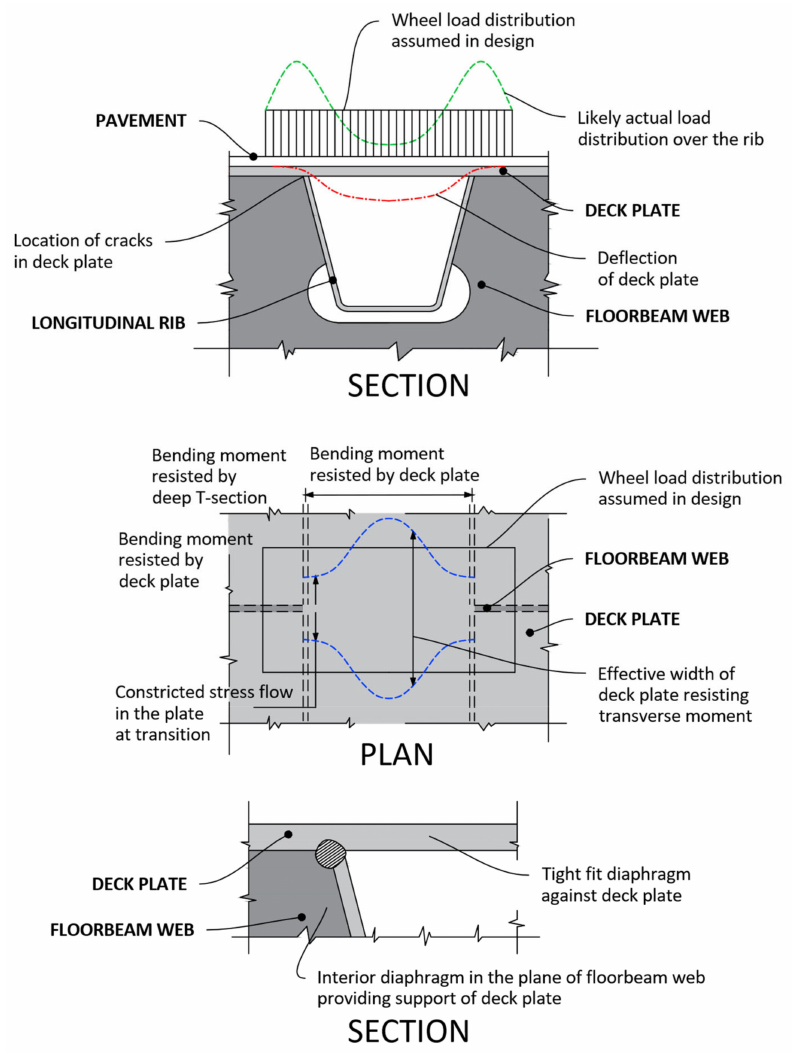
Figure 4. Rib connection-cross beam